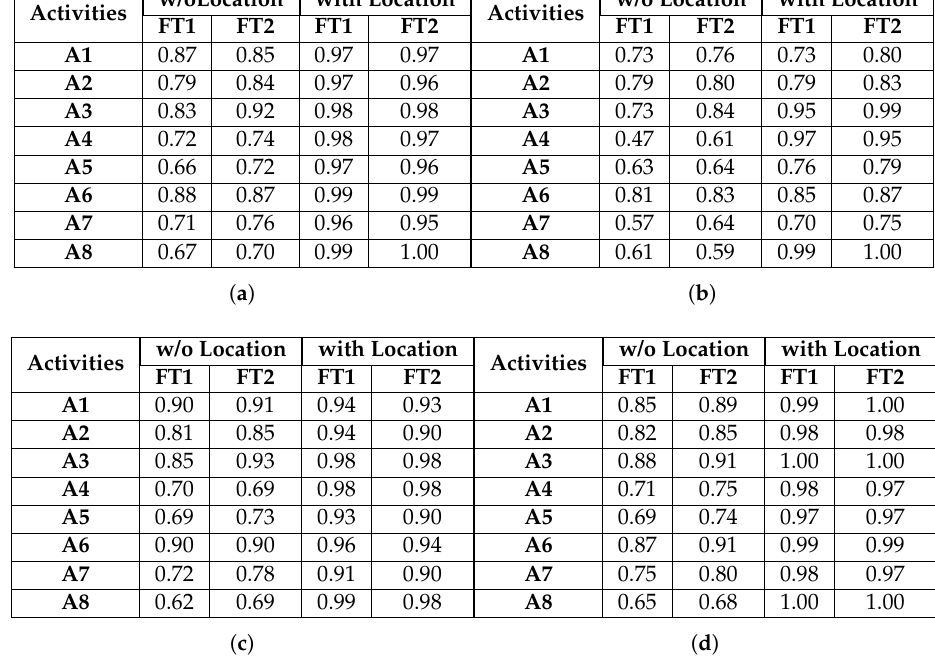
Figure 9. F 1 Scores for all classifiers and activities, for a window size of 3 s. ( a ) KNN; ( b ) LR; ( c ) RF; ( d ) SVM.